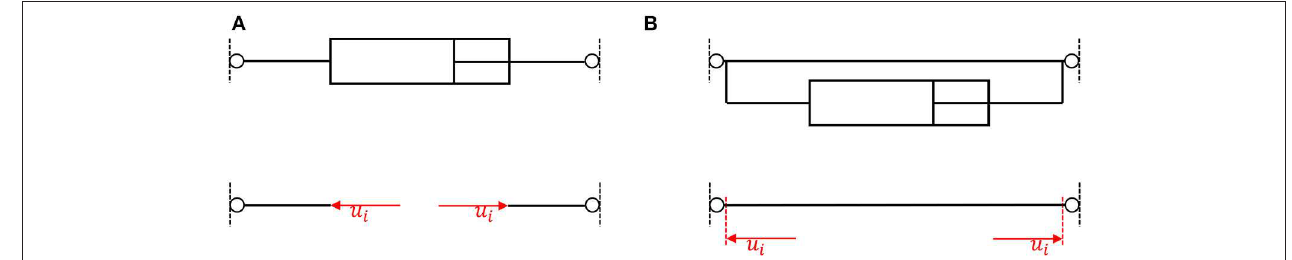
FIGURE 1 | (A) Serial actuation and (B) parallel actuation and their respective free-body diagrams.